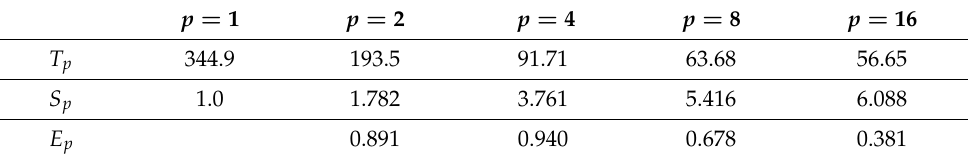
Table 4. The Crank–Nicolson discrete scheme: the values of the speedup S p and efficiency E p numbers for a sequence of cores p